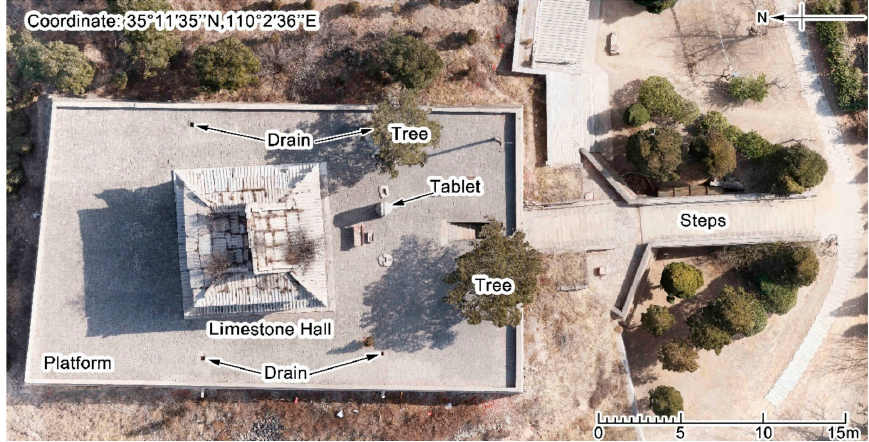
Figure 1. General layout orthophoto of the Limestone Hall.